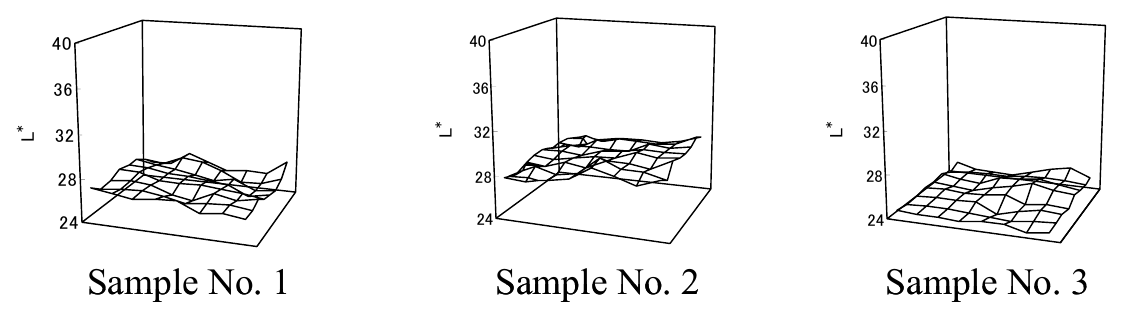
Figure 5. L* values in dyed cloth